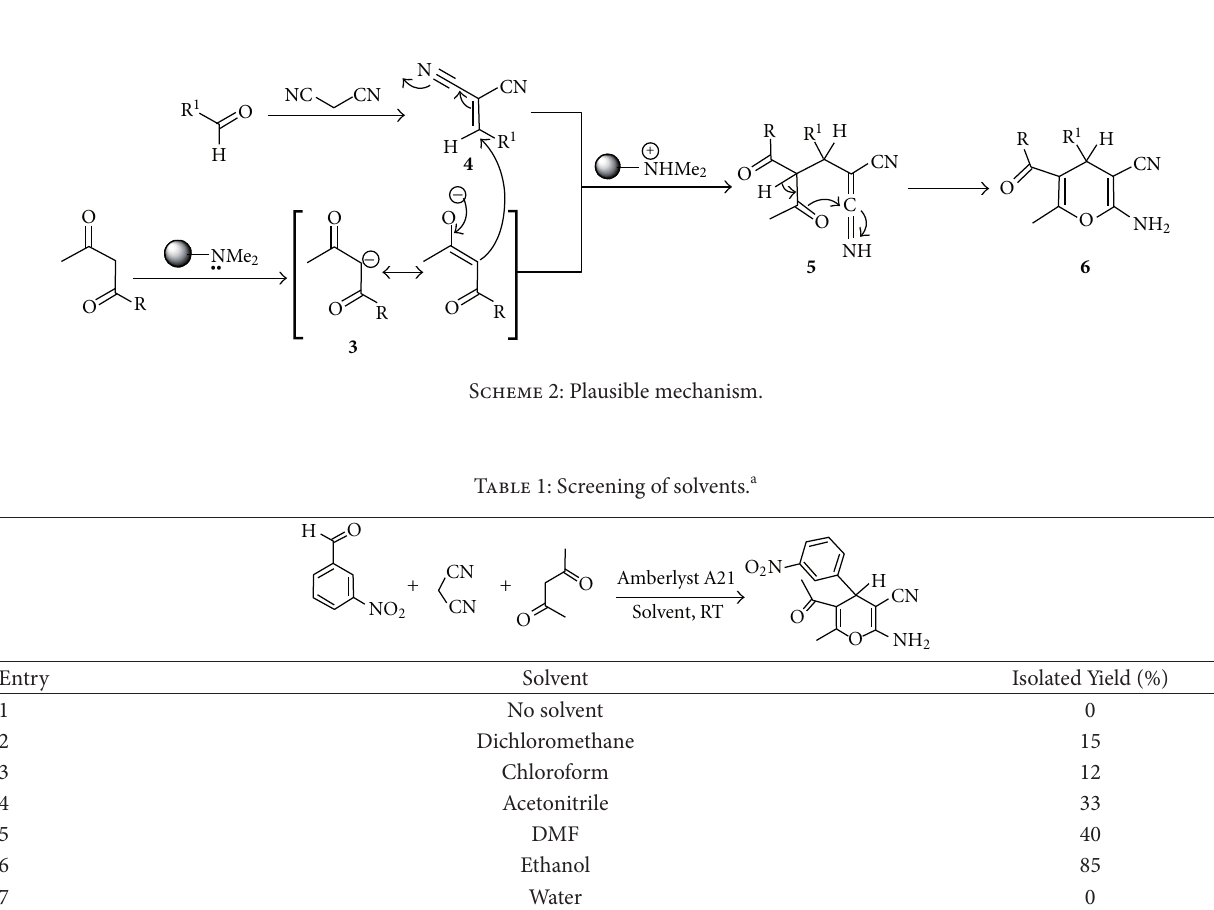
S 1: Synthesis of polysubstituted 4 H -pyran.